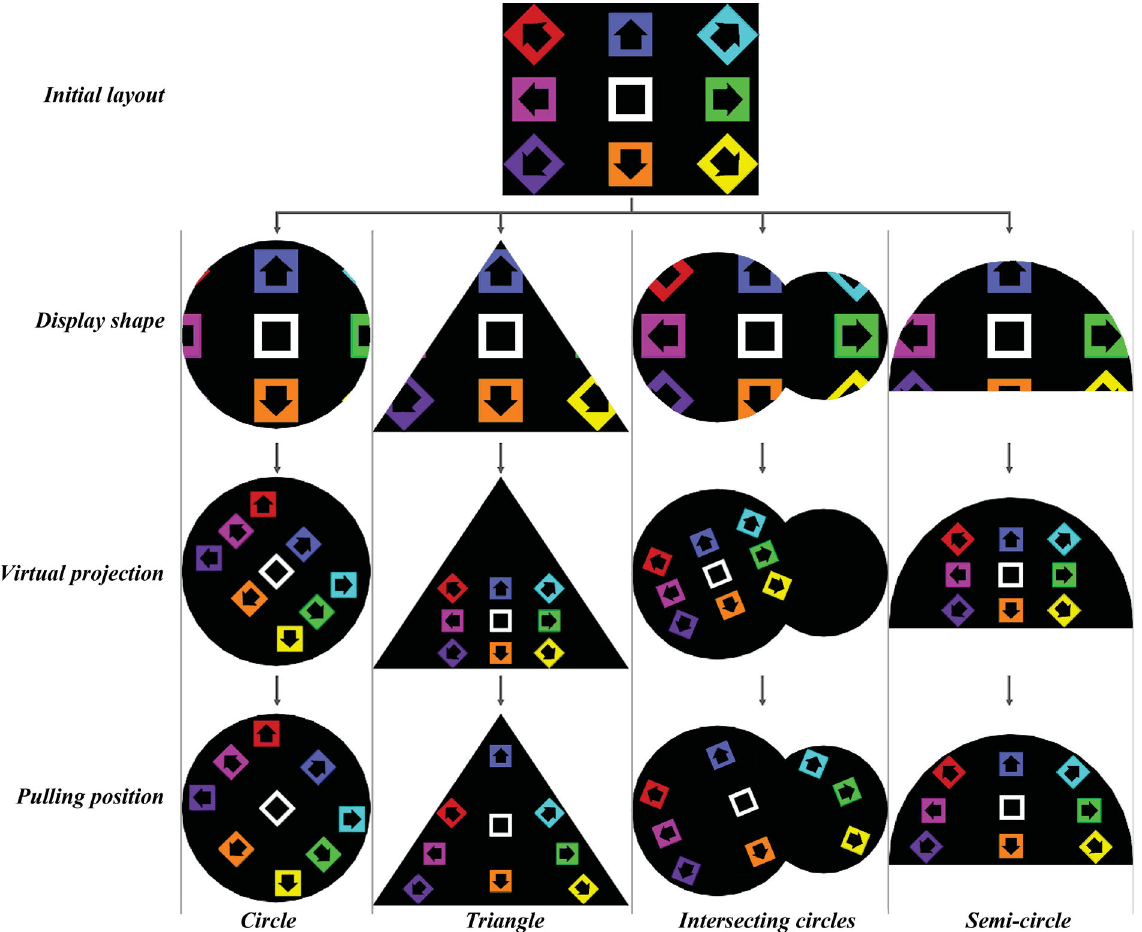
Fig. 8 Influence of our technique on SynergyNet ’s Grid